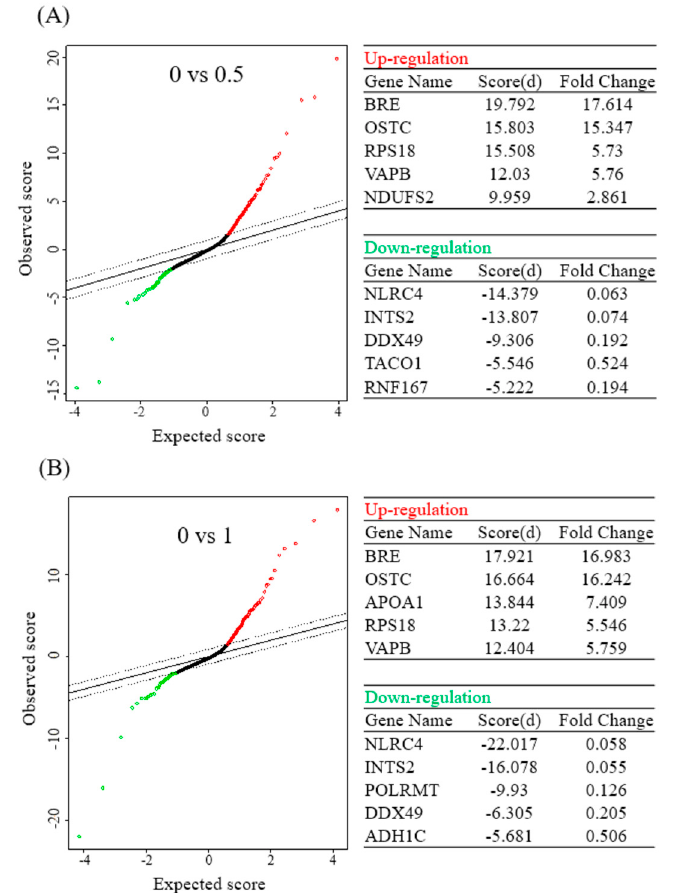
Figure 3. Significant analysis of microarray (SAM) in betulinic acid (BA)-treated Mia PaCa-2 cells and the corresponding control (no treatment). Tables show the top five differentially upregulated and downregulated protein-coding genes under 0.5 ( A ) and 1 μ M ( B ) of BA treatment (with a false detection rate (FDR) of <0.01).